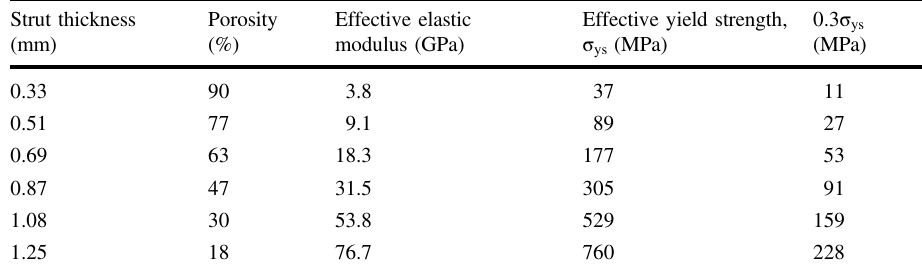
Table 1 Properties of BCC Ti- 6Al-4V porous